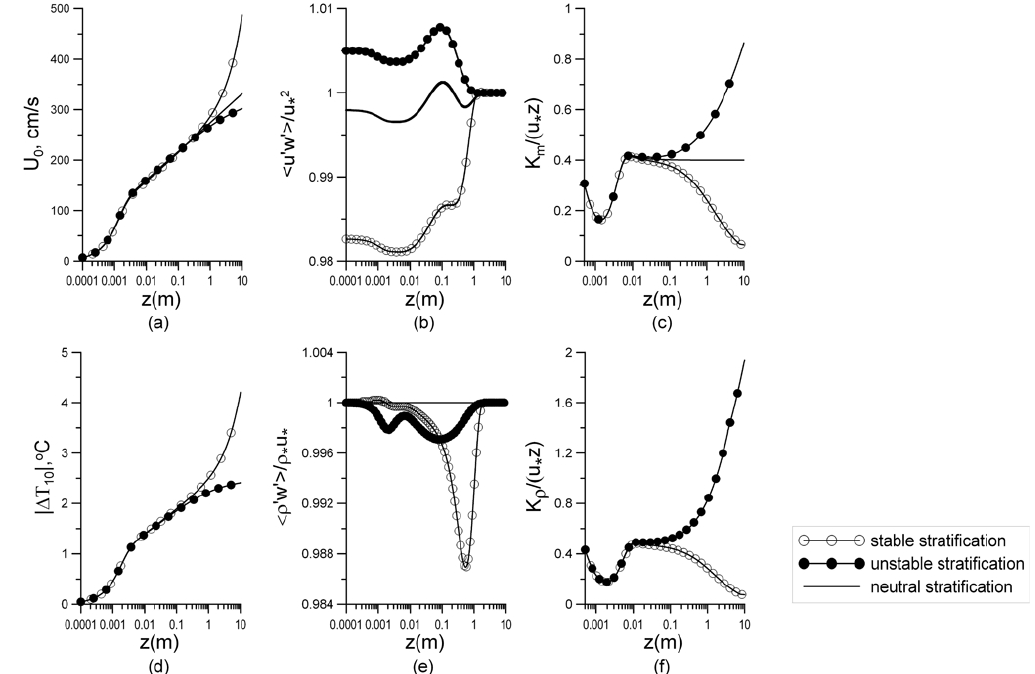
Fig. 2. The same as in Fig. 1 for kL =